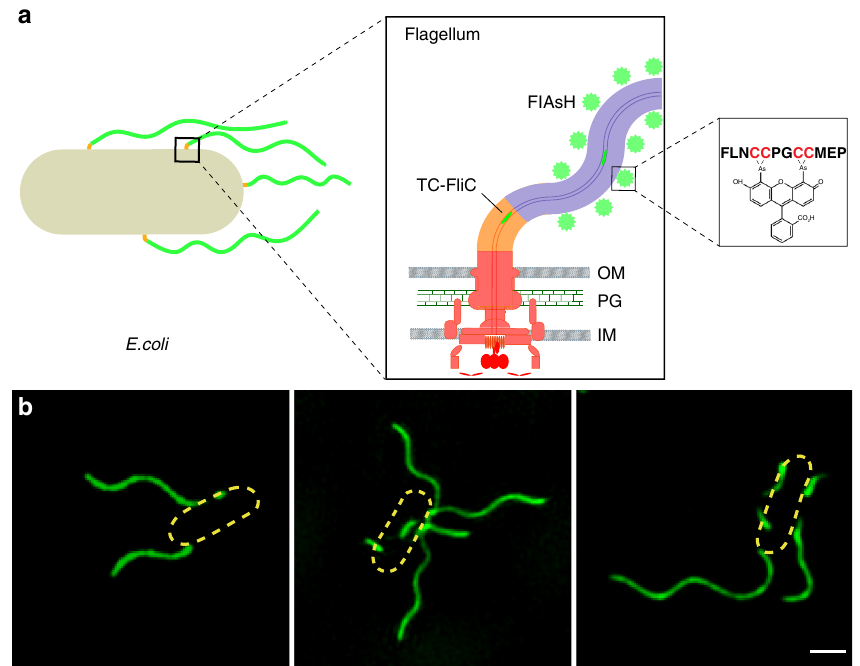
Fig. 1 Bacterial fl agella of E. coli . a A schematic illustration of the optimized tetracysteine tag (FLNCCPGCCMEP) inserted fl agellins labeled by the biarsenical fl uorophore FlAsH. b Representative super-resolution fl uorescent images of E. coli peritrichous fl agella acquired by the Structured Illumination Microscopy (SIM). Scale bar = 1 µ